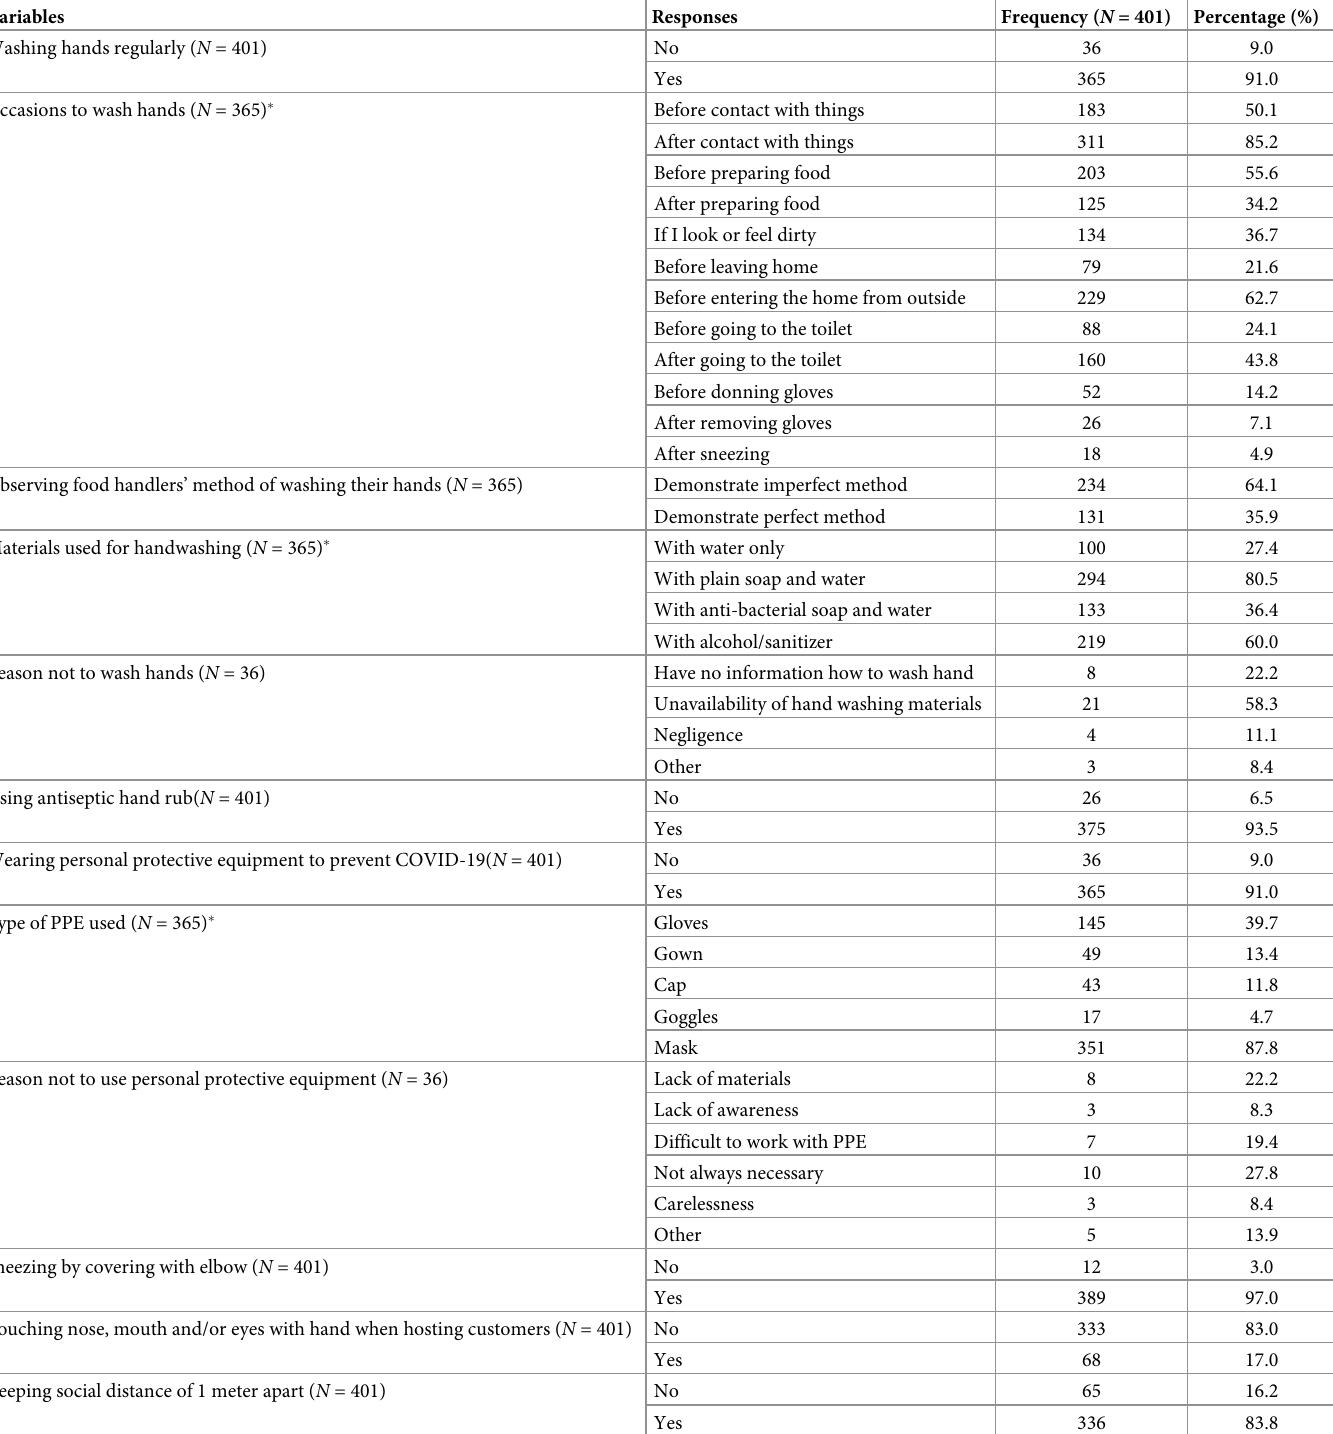
Table 6. Frequency and percentage distribution of infection prevention practices related to COVID-19 among food handlers at food and drink establishments in Dessie City and Kombolcha Town, Northeastern Ethiopia, July–August